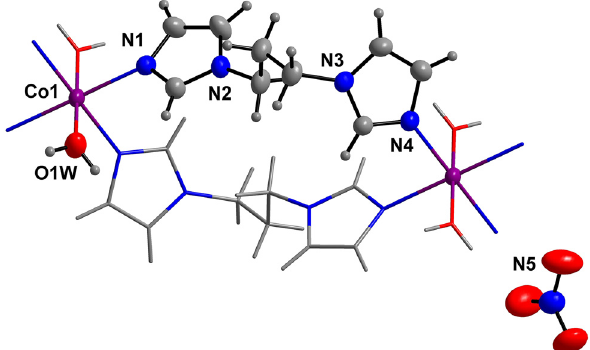
Table  : Data collection and